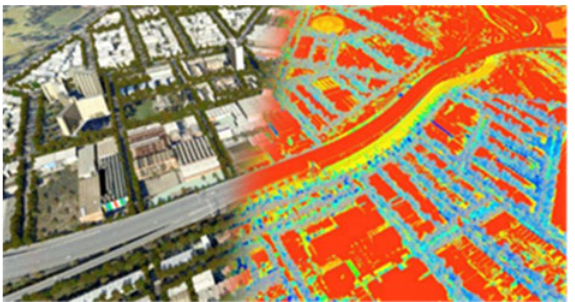
Figure 2: 3D digital model solar impact study using algorithmic botany